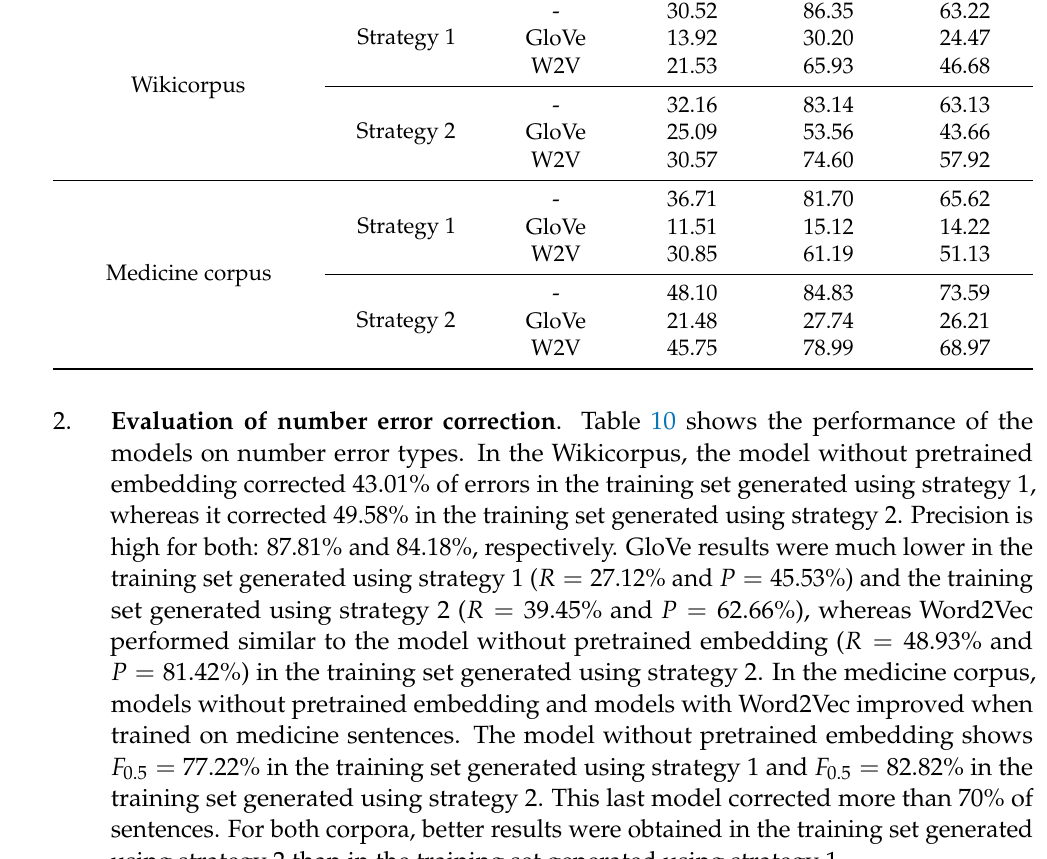
Table 9. Recall ( R ), precision ( P ) and F 0.5 for the evaluation of genre error correction. Training Strategy